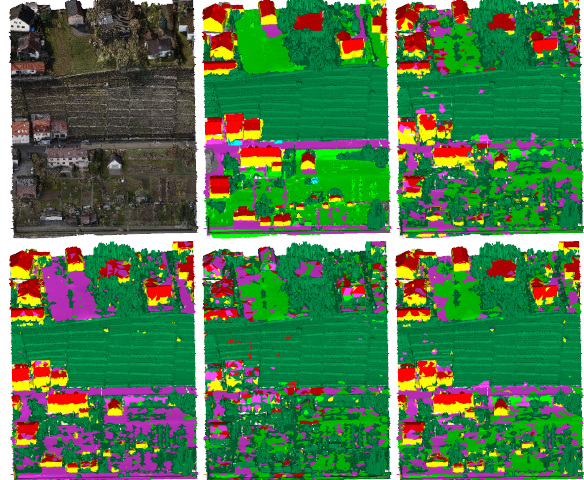
Figure 5. Impact of different feature vector compositions with respect to Table 4. From left to right, top to bottom: Textured Tile B, ground truth labeled mesh,